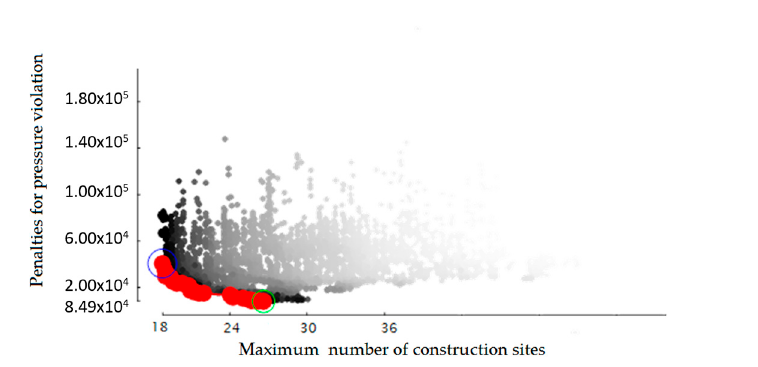
Figure 6. Obtained Pareto front: trade-off between the maximum number of construction sites and the penalties for the violation of the minimum desirable pressure (red). The grey dots represent previous solutions obtained during the optimization process.